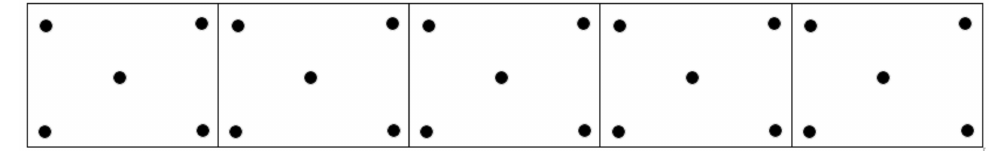
Figure 1. Example of Stimuli from the Five-Point